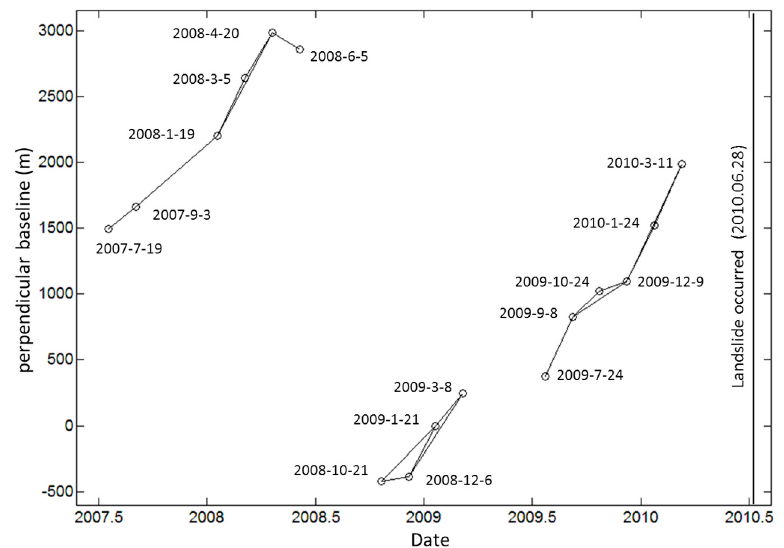
Figure 2. The configuration of the temporal and spatial baseline of the interferometric pairs, where the vertical line indicates the date on which the landslide occurred.